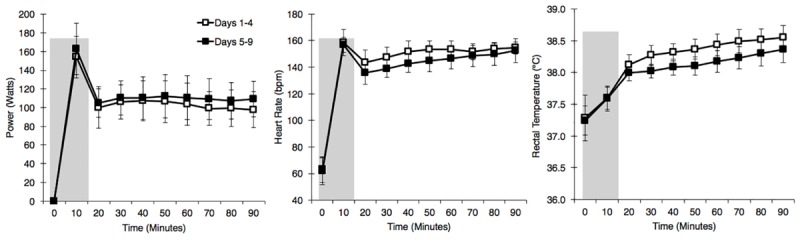
Power output (left), heart rate (middle), and rectal temperature (right), at 10 min intervals during the heat acclimation protocol. Open squares represent mean ± SD of data from days 1 to 4, and solid squares represent mean ± SD of data from days 5 to 9. Shaded area represents a 15-min time trial or 15-min high-intensity intervals.